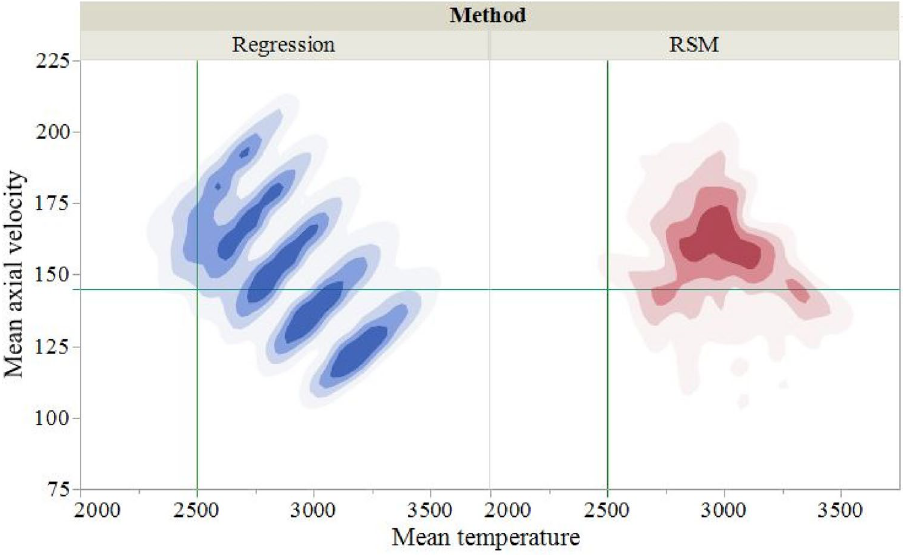
Figure 7. Contour plots of the data density for the RA and the RSM models from the 625 values of the input parameters. Note that the line T = 2500 K intersects the blue region corresponding to the RA but not the red region corresponding to the